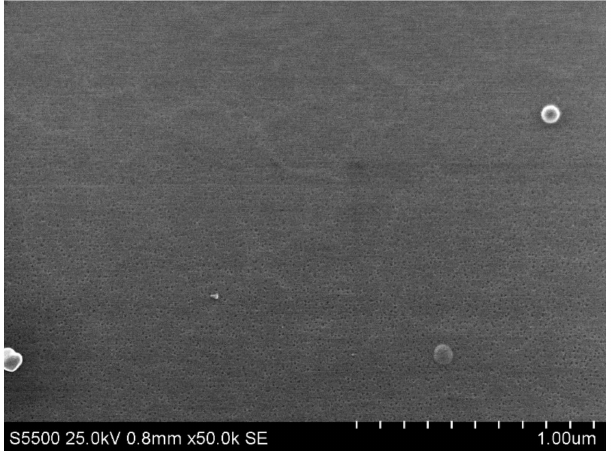
Figure 4. Scanning electron microscopy (SEM) image of the surface morphology of a silicon